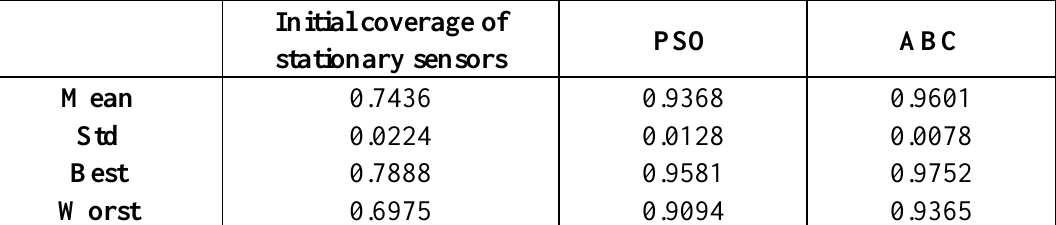
Table 1. Probabilistic Dynamic Deployment